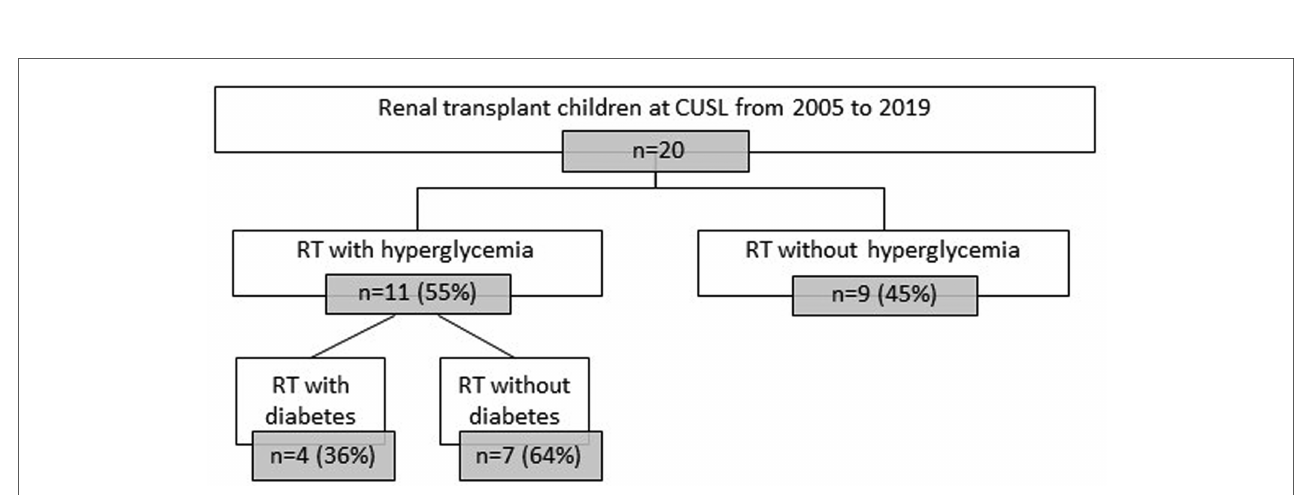
FIGURE 3 Flowchart of rDIABGRAFT pediatric RT cohort. Out of 20 pediatric patients who bene fi ted from a renal transplant in the Cliniques universitaires Saint Luc (CUSL) between April 2004 and December 2019, eleven (55%) presented hyperglycemia. Out of them, four (20%) developed overt diabetes and the remaining seven (35%) patients presented HG without overt diabetes. n: number of patients, RT: renal